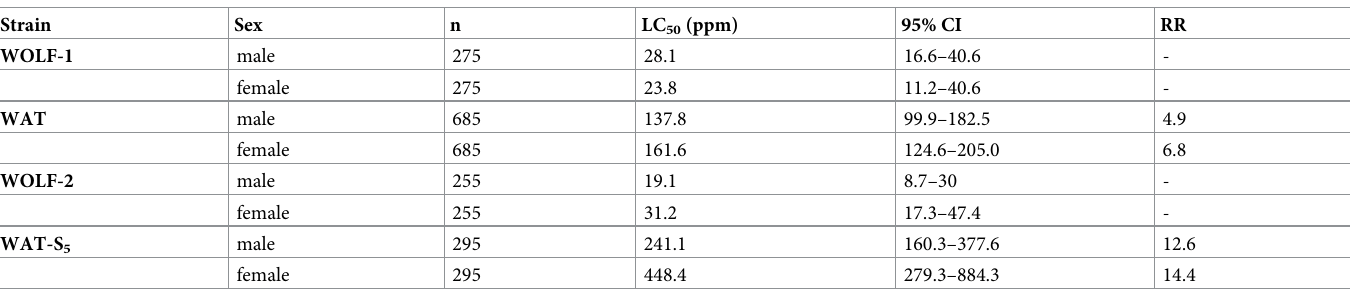
Table 3. Adult susceptibility of WOLF-1, WOLF-2, WAT and WAT-S 5 D . suzukii to spinosad. Strain